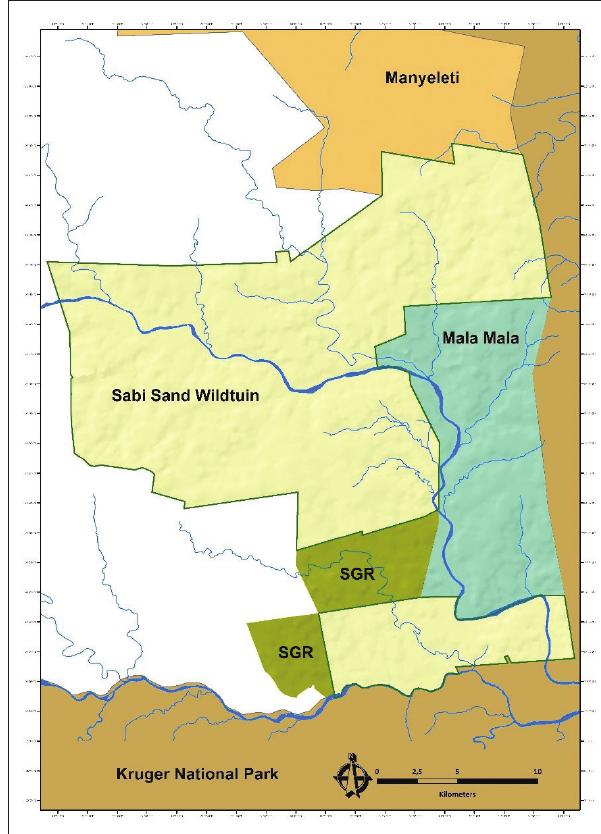
FIGURE 1: Sabi Sand Wildtuin in South